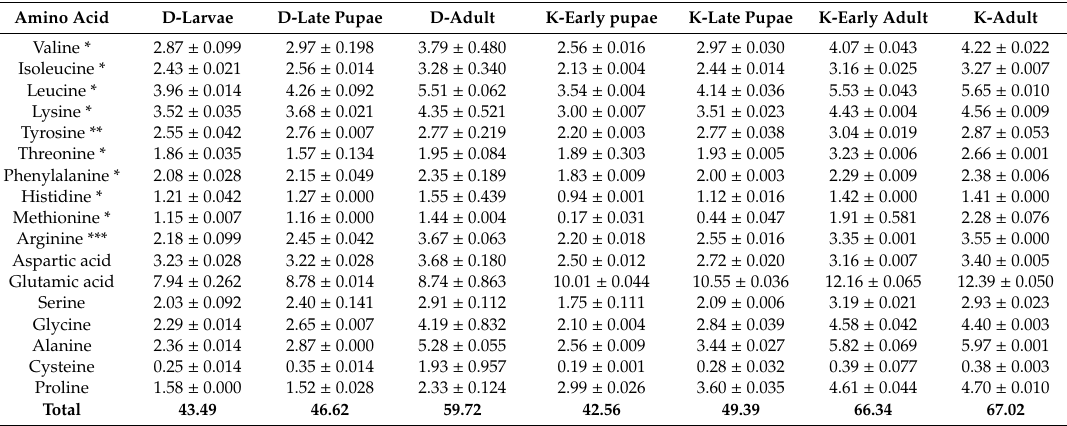
Table 1. Amino acid composition (g / 100 g dry matter basis) of di ff erent developmental stages of Italian honey bee drones from Korea (K-) and Buckfast honey bee drones from Denmark (D-). Amino Acid D-Larvae D-Late Pupae D-Adult K-Early